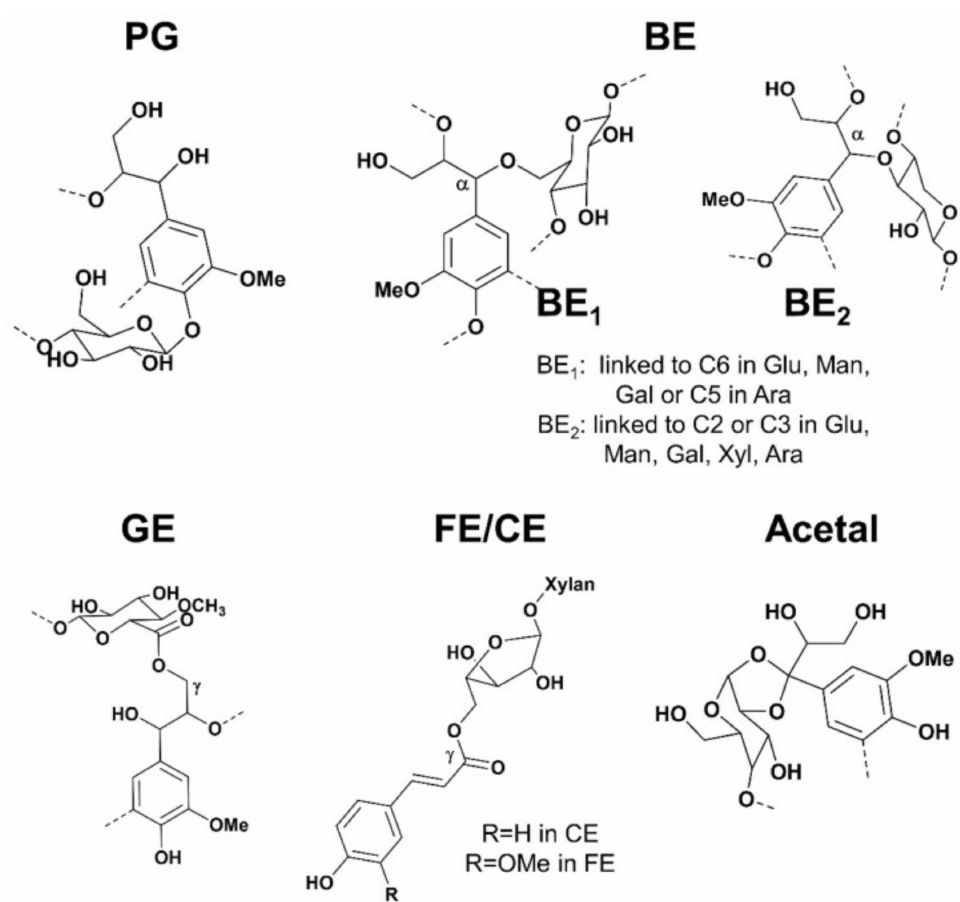
Figure 16. Lignin-Carbohydrate Bonds (LC) suggested structures in wood and grass. PG = phenyl glycosides, BE = benzyl ethers; GE = γ -esters; FE = ferulate esters; CE = coumarate